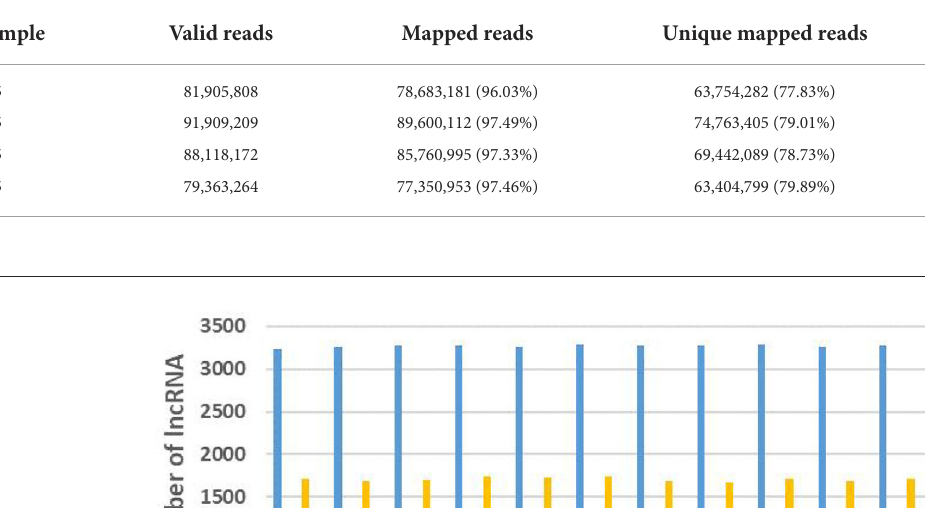
TABLE 2 Reference genome alignment read statistics.